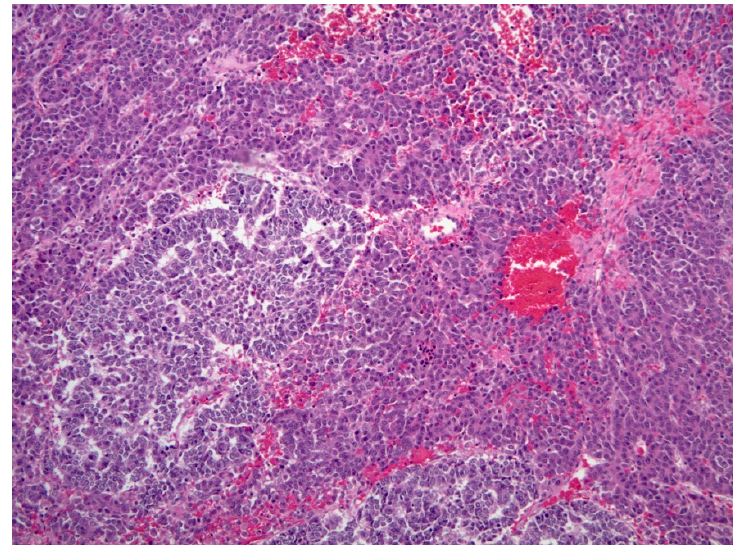
Figure 6. Hepatoblastoma (H&E, 10× magnification). Mixed embryonal (left) and fetal hepatoblas- toma. The embryonal component demonstrates a higher nuclear-to-cytoplasmic (N:C) ratio and forms rosette-like structures, while the fetal component recapitulates the appearance of fetal hepatocytes.